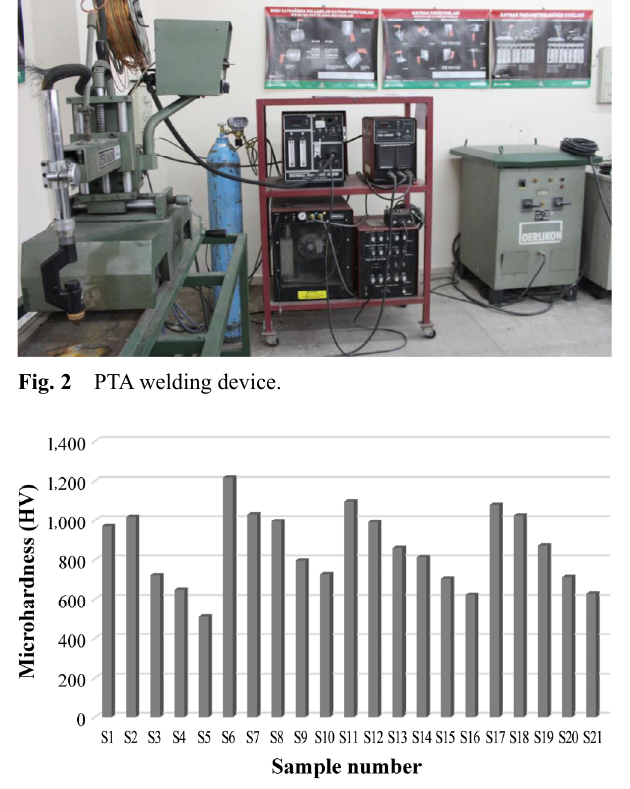
Average microhardness values of samples.